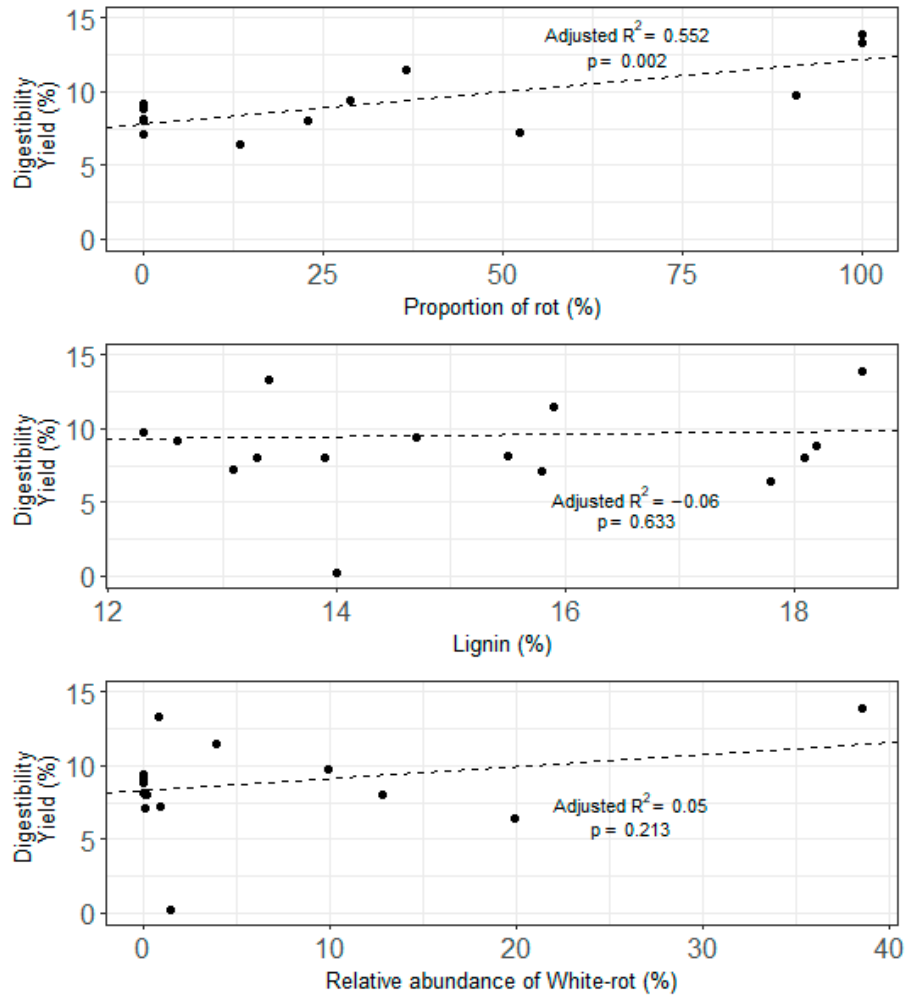
Figure 7. Relationships between proportion of wood area affected by rot, lignin content and rela ‐ tive abundance of white ‐ rot fungi compared to all saprotrophs, and digestibility yield of carbohy ‐ drates.